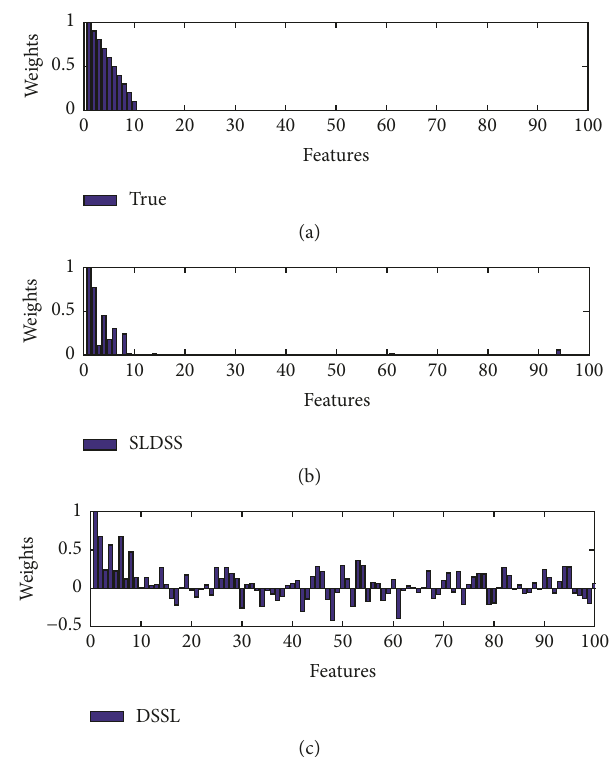
Figure 1: Synthetic example. Comparison of learned weight vectors (normalized)ofsparseSLDSSmethodanddenseDSSLmethodwith the ground truth.